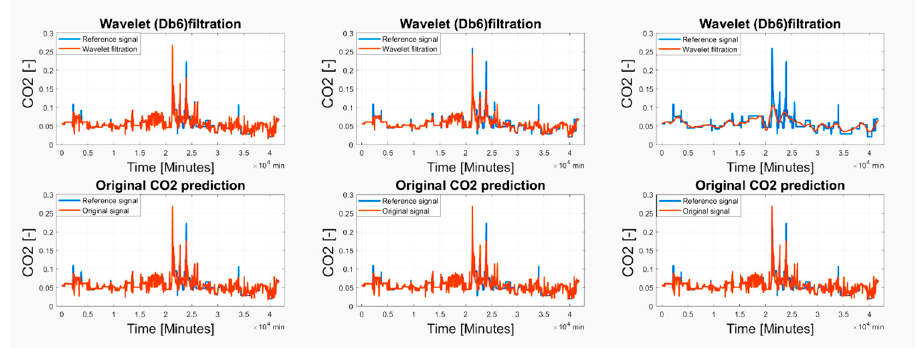
Figure 18. The comparison of the original predicted CO 2 signal and Wavelet filtration from 1–29 May 2018 for 2-level decomposition ( left ), 6-level decomposition ( middle ) and 7-level decomposition ( right ).